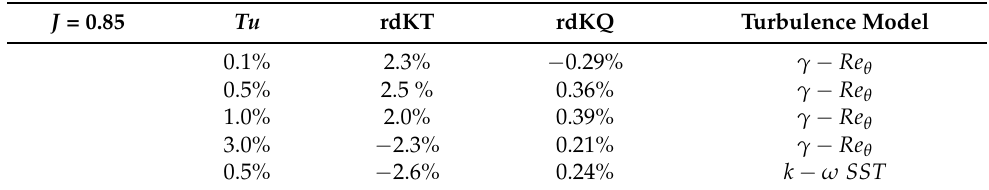
Table 11. Predicted relative differences of force coefficients for propeller A, J = 0.85, non- cavitating condition.